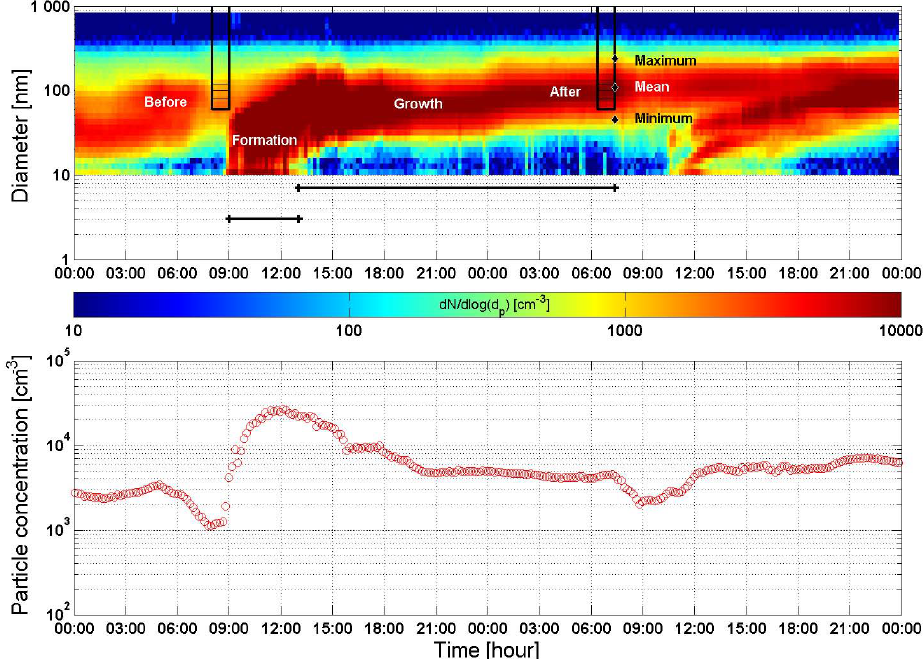
Fig. 1. Evolution of the particle size distribution during a particle formation event showing the different periods where values for analysis are calculated. “Before” is the one hour period before the new 10-nm particles appear, typically just after atmospheric mixing which results in the observed decrease in total particle concentration and breakup of the temperature inversion. “After” is the one hour period at the end of particle growth, but before the start of the next nucleation event. Small horizontal lines in “before” and “after” represent the lower size limits for CCN; 60nm, 80nm, 100nm and 120nm. “Formation” is the period when 10-nm particles appear whereas “growth” is the period from end of “formation” until “after”. The values used are median values for each period. The formation period is not the same as nucleation period as the particles nucleate at sizes of ∼ 1–2nm. This means the particles appear at 10nm only approximately 0.5–4h after they are